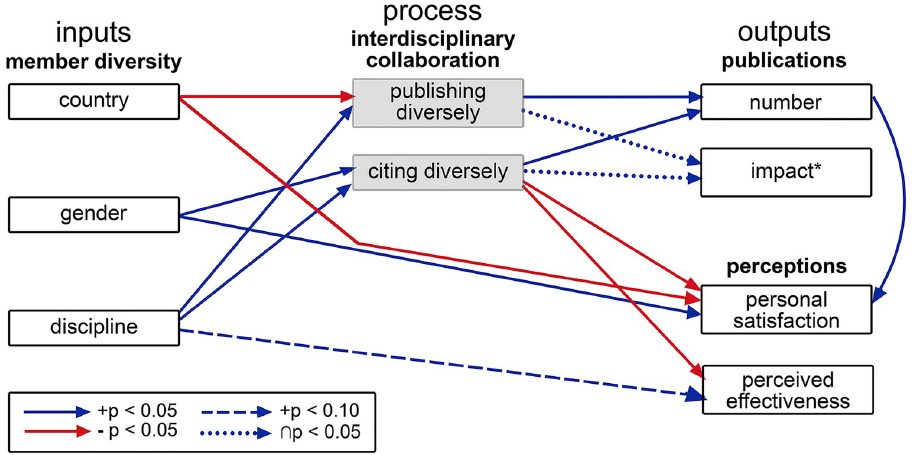
Fig 4. Model output. Graphical summary of the quantitative results. � specifically median citations received by each